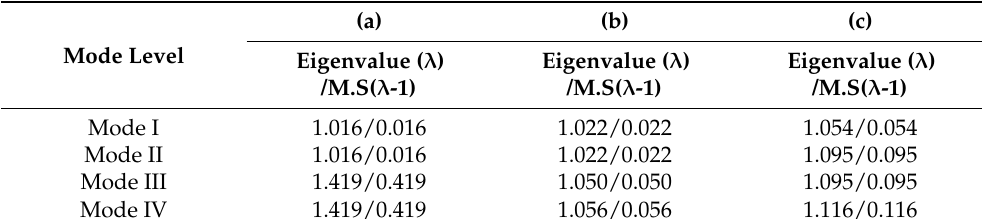
Table 4. Comparison results of each model’s stability analysis.